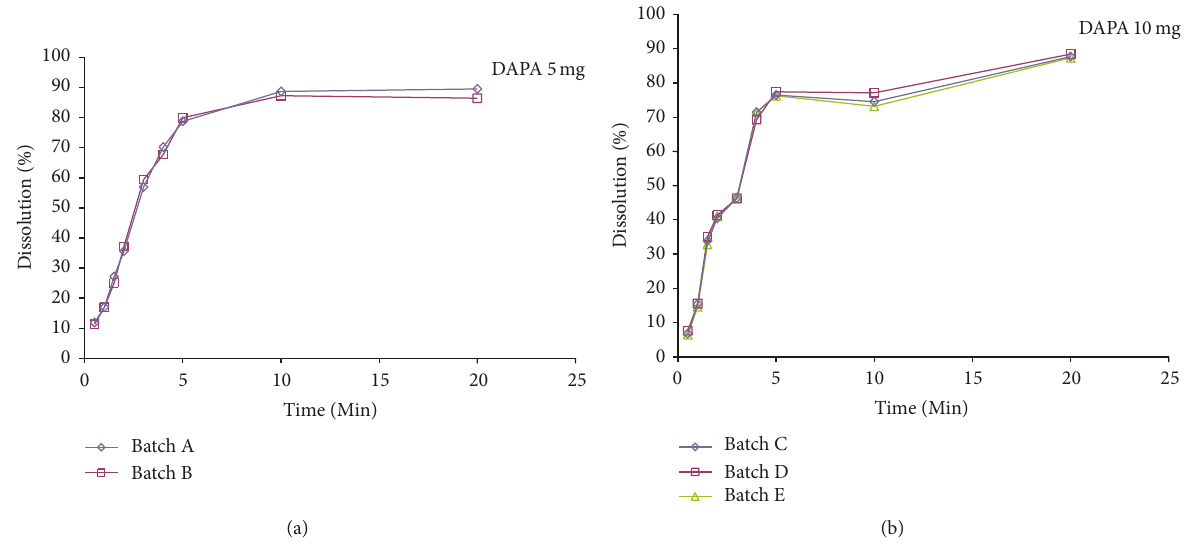
Figure 4: Dissolution profile of two batches of Forxiga 5 mg (a) and three bathes of Forxiga 10mg (b).